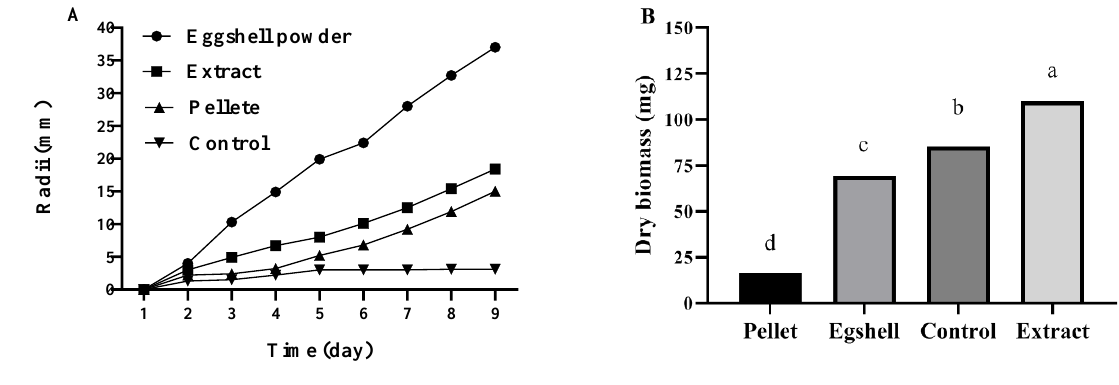
Fig. 4 Effect of eggshell extraction on S. indica radial growth and mycelia mat yield A . Calculated mean radii of S. indica on solidified broth medium measured on four perpendicular axes bisecting the center of the colony. ( Note: The diameter of the fungus was divided by its average growth. S. indica was grown on the solidified broth cultures supplemented with 0.1% eggshell powder (w/v), 0.1% eggshell extract and 0.1% eggshell pellet (concentrated eggshell particles after centrifugation). P < 0.05. Values are mean ± SE (n = 5). B , The mycelia mats (dry biomass) yield of S. indica in medium supplemented with 0.1% eggshell powder (w/v), 0.1% eggshell extract and 0.1% eggshell pellet. ( Note: The mycelia mats were harvested from the liquid media after 4 weeks). P < 0.05. Values are mean ± SE (n =